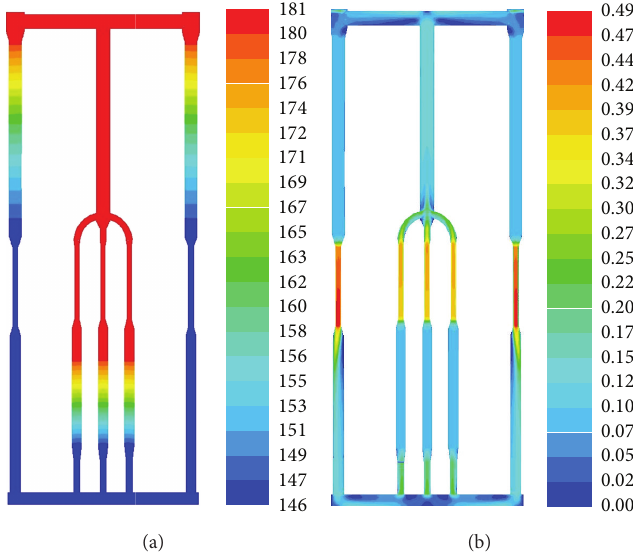
Figure 6: Flow fields in the test section: (a) temperature field; (b) velocity